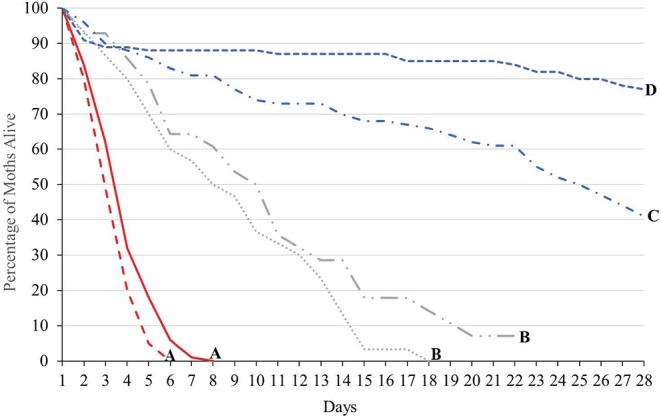
Longevity of 2 strains of P. xylostella under 3 different conditions in the laboratory: 100 males (, GA; , OX4319L) not provided 7.5% sugar water daily; 100 males (, GA; , OX4319L) provided 7.5% sugar water daily; 28 GA females (, mated to GA males) and 30 GA females (, mated to OX4319L males) from intrinsic growth rate study (see text). Lines with the same letter are not significantly different as determined by Tukey's HSD test, HSD0.05, 6 = 2.87.